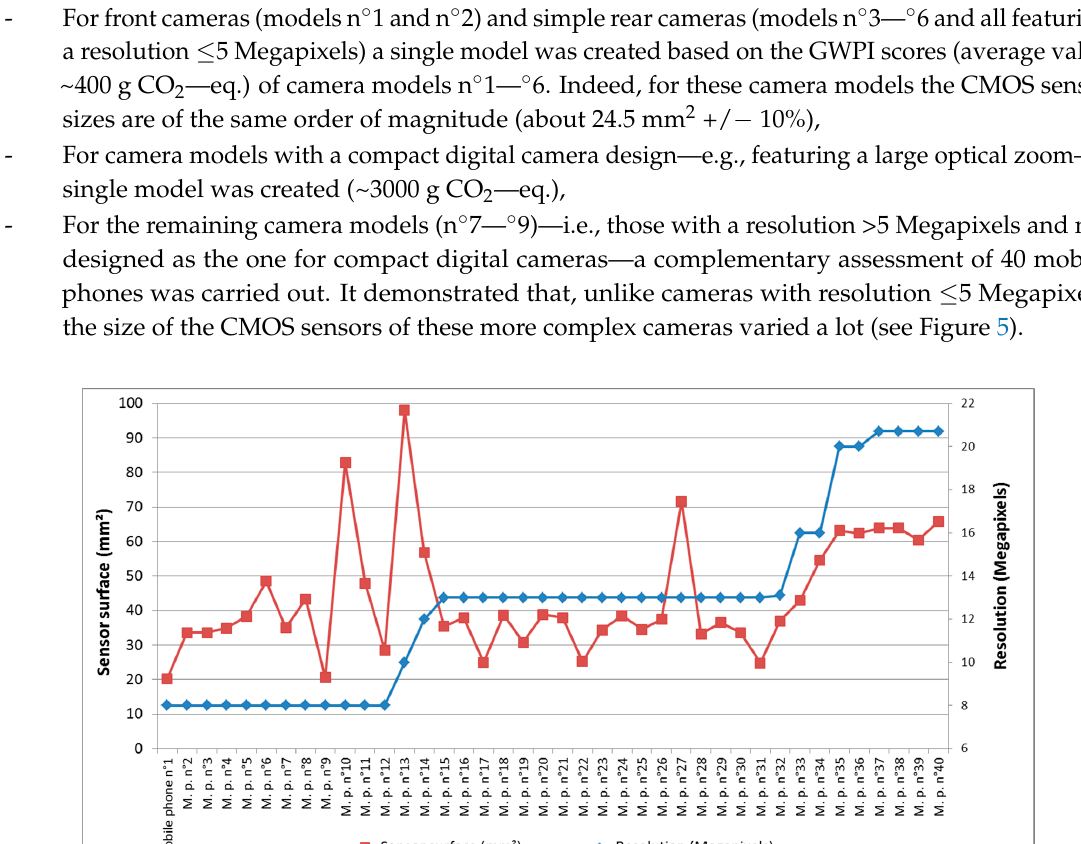
Figure 5. Relationship between camera resolution and sensor surface.